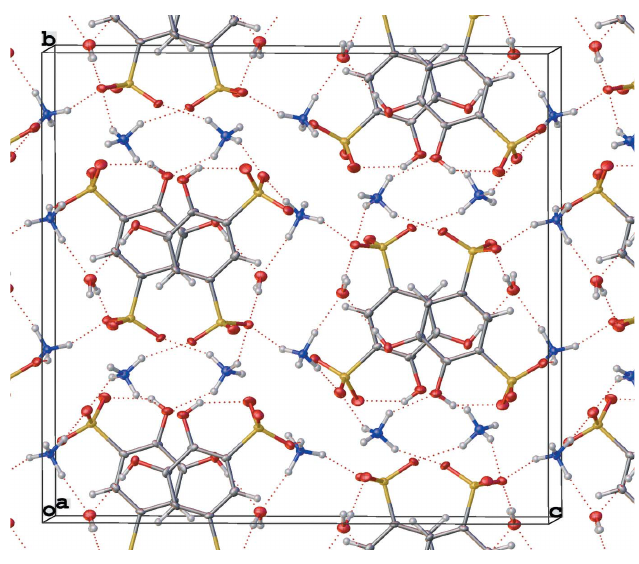
Figure 10 Extended packing view of (NH 4 ) 2 (tiron) structure showing the three- dimensional H-bond